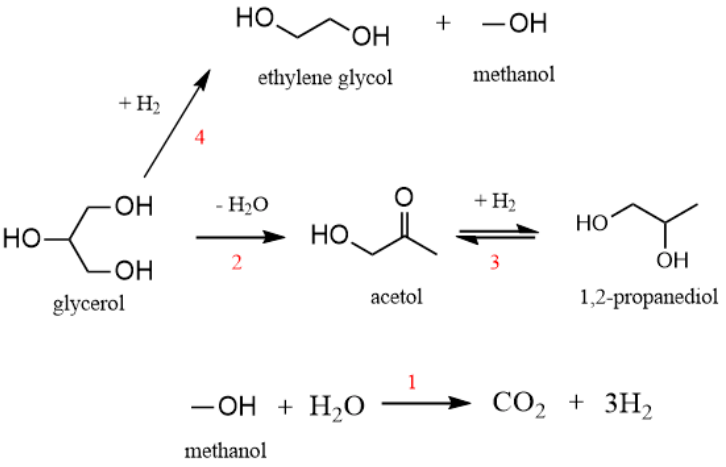
Figure 3. Simplified scheme of glycerol hydrogenolysis reaction mechanism.